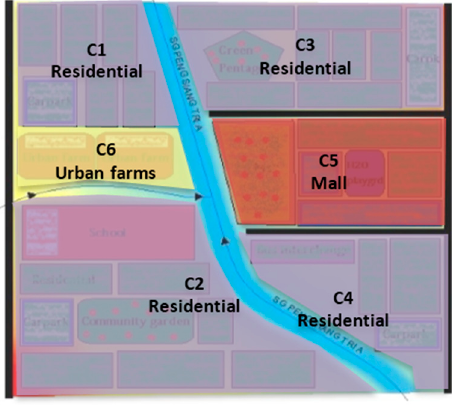
Figure 8. TSC Subcatchments in SWMM.